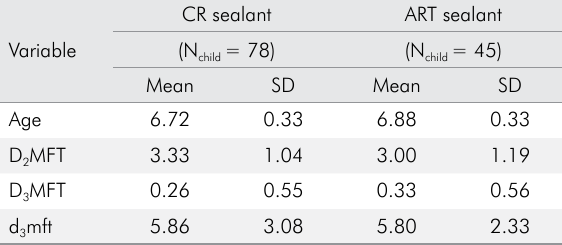
Nchild: number of children; CR: composite resin; ART: atraumatic restorative treatment. Age, p < 0.01; D2MFT, p = 0.11 ; D3MFT, p = 0.46; d3mft, p =